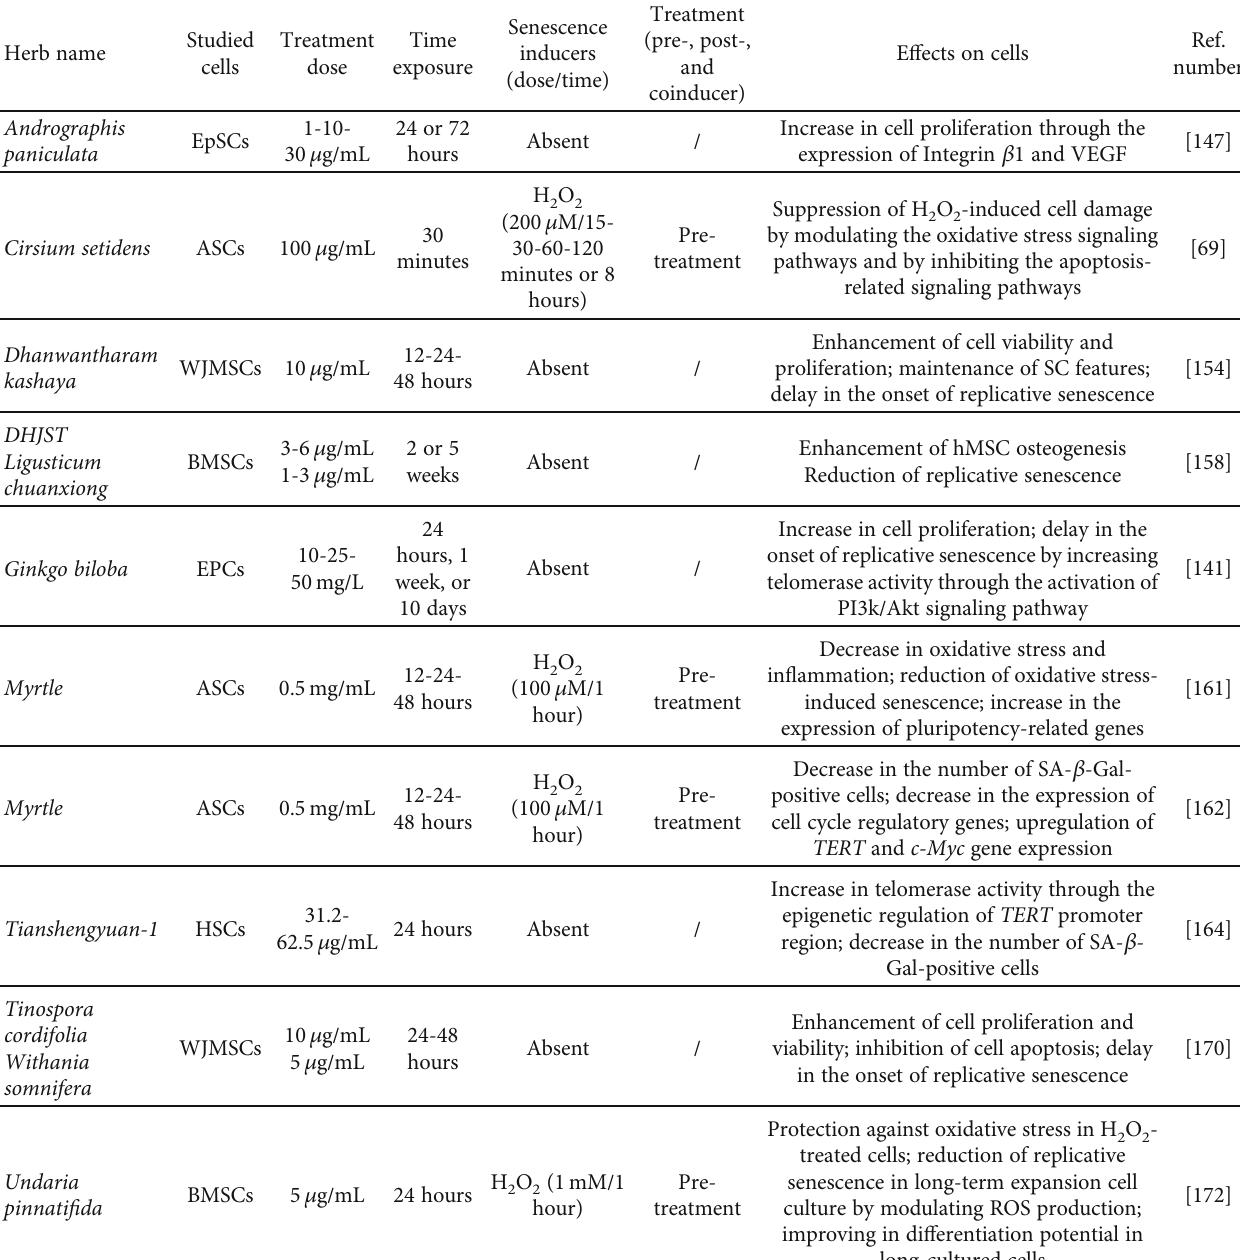
Table 2: Herb-derived products with an antisenescence role on human ex vivo cultured tissue-derived